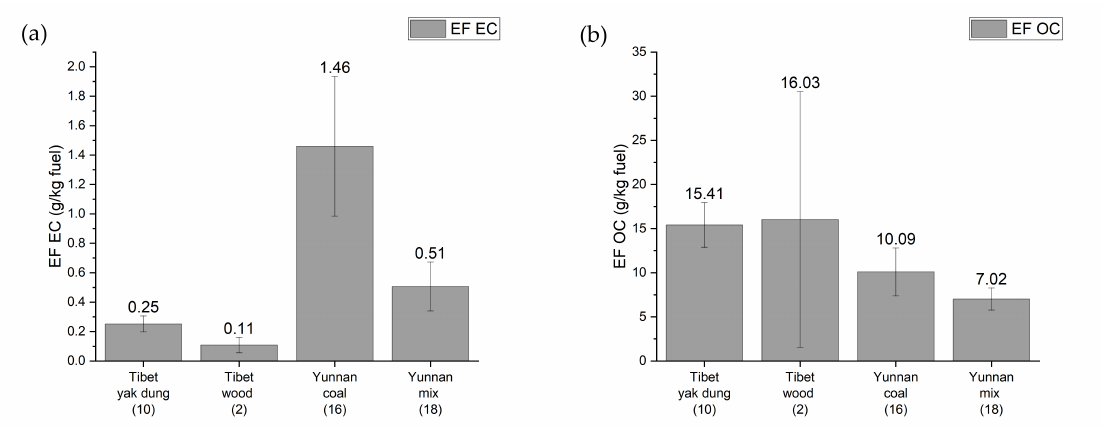
Figure 10. Comparison of carbon particulate emission factor between sites and fuels: ( a ) Elemental carbon; ( b ) Organic carbon.